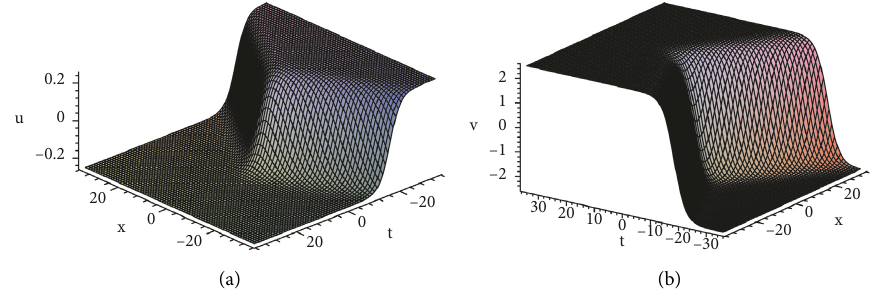
Figure 1: The propagation for u (bright) and v (gray) is plotted in (a) and (b), respectively.